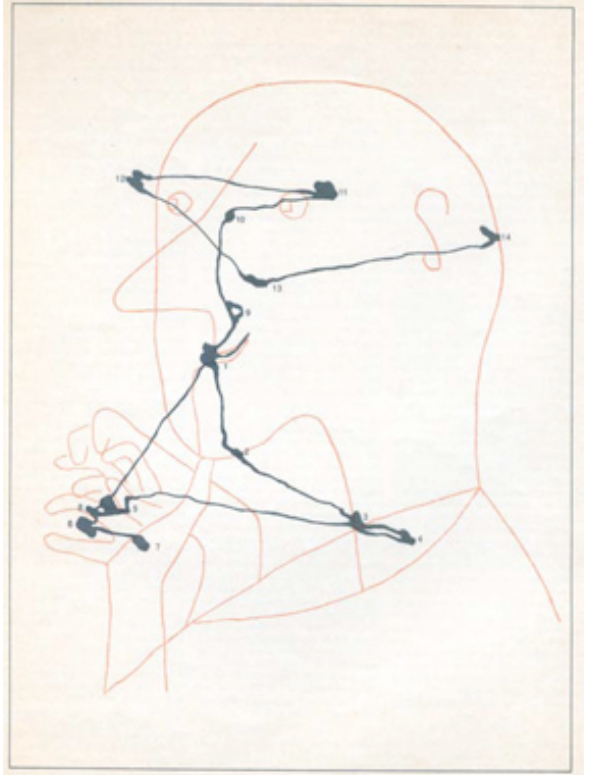
Figure 1. Eye movements made by a subject viewing for the first time a drawing adapted from Paul Klee’s ”Old Man Figuring” appear in black. Numbers show the order of the subject’s visual fixations on the picture during part of a 20-second viewing. Lines between them represent saccades from one fixation to the next. Saccades occupy about 10% of viewing time. (from Noton & Stark, 1971, Scientific America)